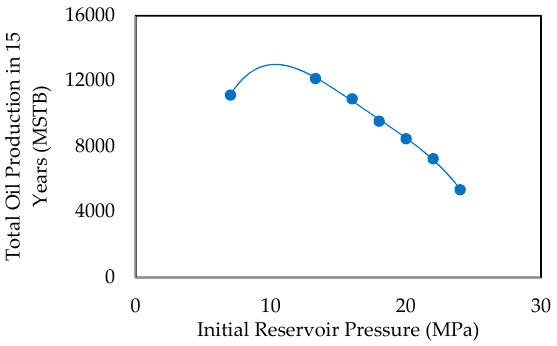
Figure 13. Variation of oil production with initial reservoir pressure in WAG process.